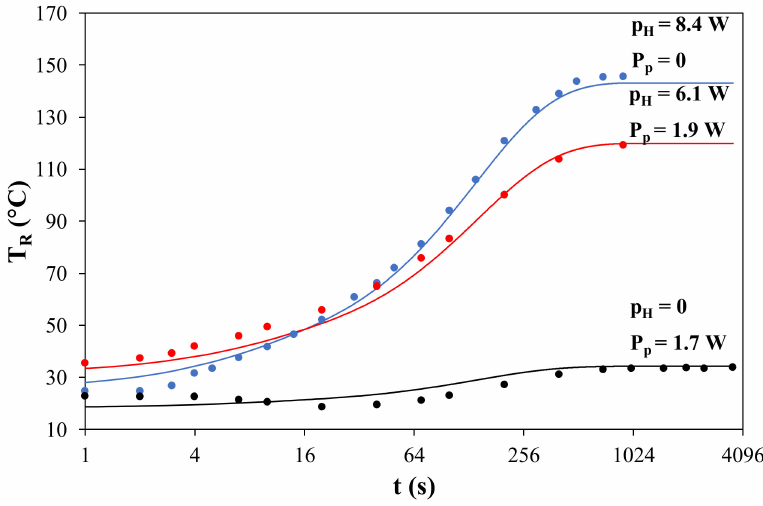
Figure 17. Measured and computed heating curves of the internal temperature of the resistor operating with the Peltier module (system